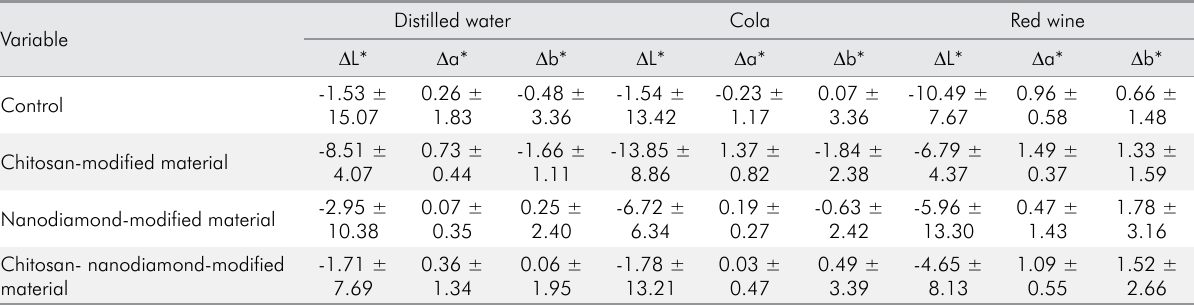
Table 5. Mean and standard deviation of the three color parameters ( Δ L*, Δ a* and Δ b*) of the materials after aging in different